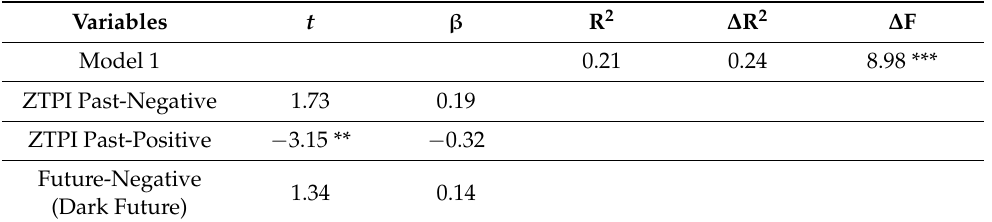
Table 3. Linear regression results for types of parents’ time perspective as predictors of parents’ posttraumatic stress disorder symptoms ( n =